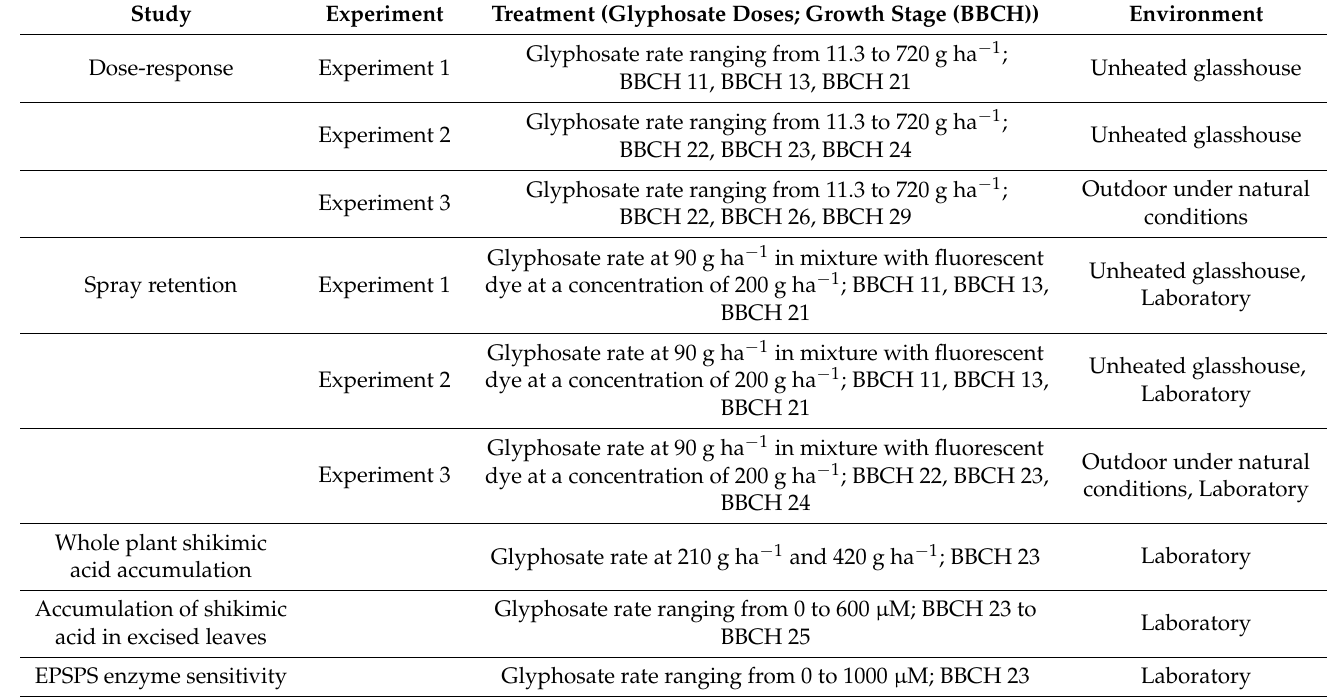
Table 1. Set-up of the different experiments carried out to examine the level and cause(s) of the lower performance of glyphosate on V. myuros